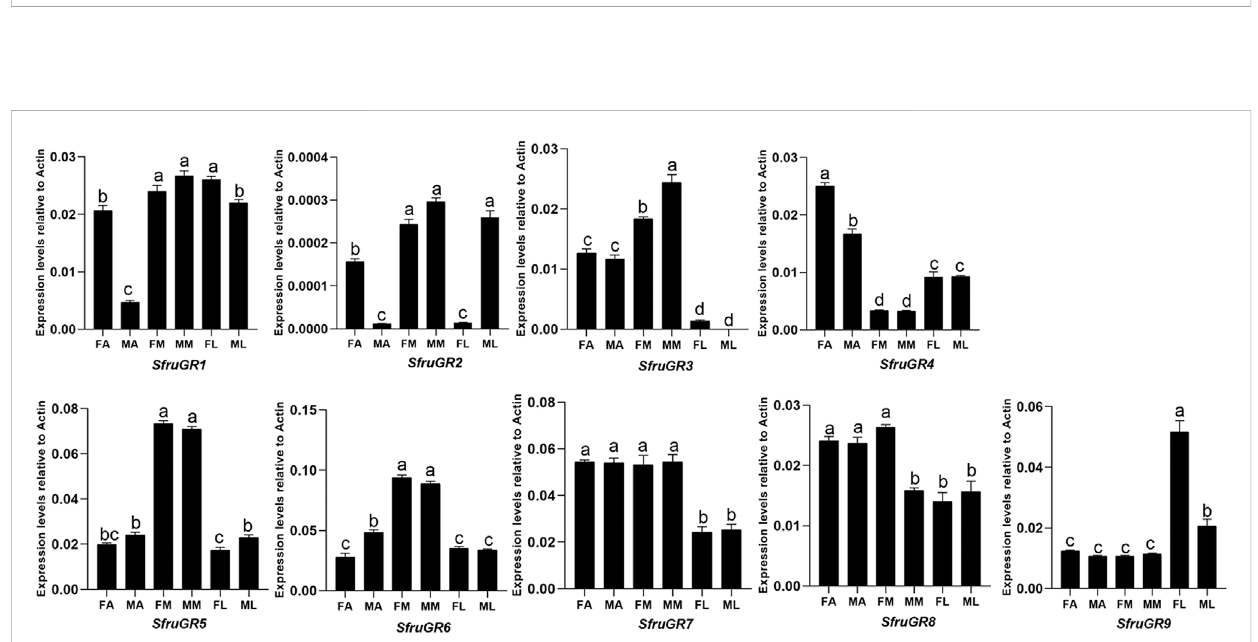
FIGURE 6 Expression patterns ofcandidate GRs indifferentchemosensorytissues ofadult S.frugiperda .RT-qPCR analysis wasconductedfor SfruGR genesin femaleantennae(FA),male antennae(MA),femalemouthparts(FM),male mouthparts (MM),femalelegs (FL), andmale legs(ML).Different letters indicate signi fi cant difference based on a one-way ANOVA followedby Tukey ’ smultiple comparison test. Error bars show the standard errors of the means (+SE), p < 0.05, n =